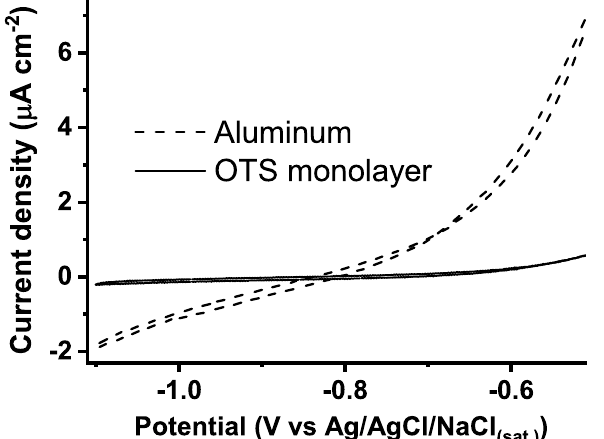
Figure 1. Cyclic voltammograms of the metallurgical aluminum surface before and after silanization at the scan rate of 10 mV s −1 in phosphate buffer, pH